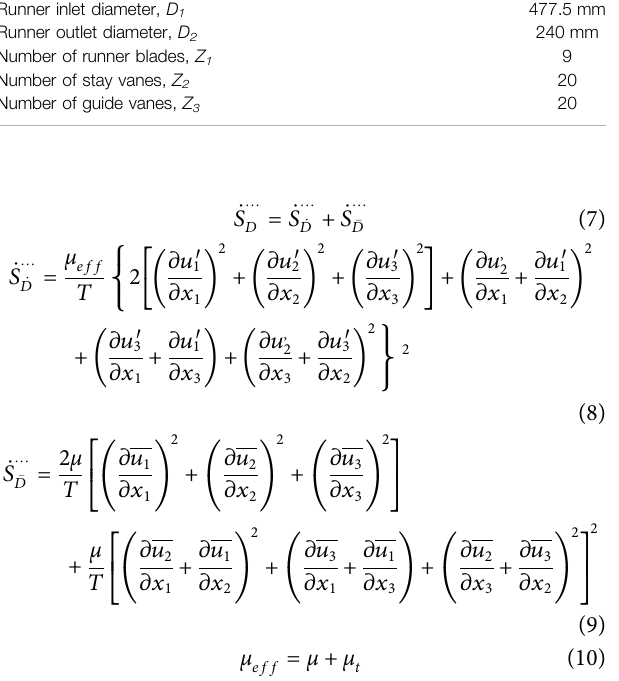
TABLE 1 | Parameters of model.